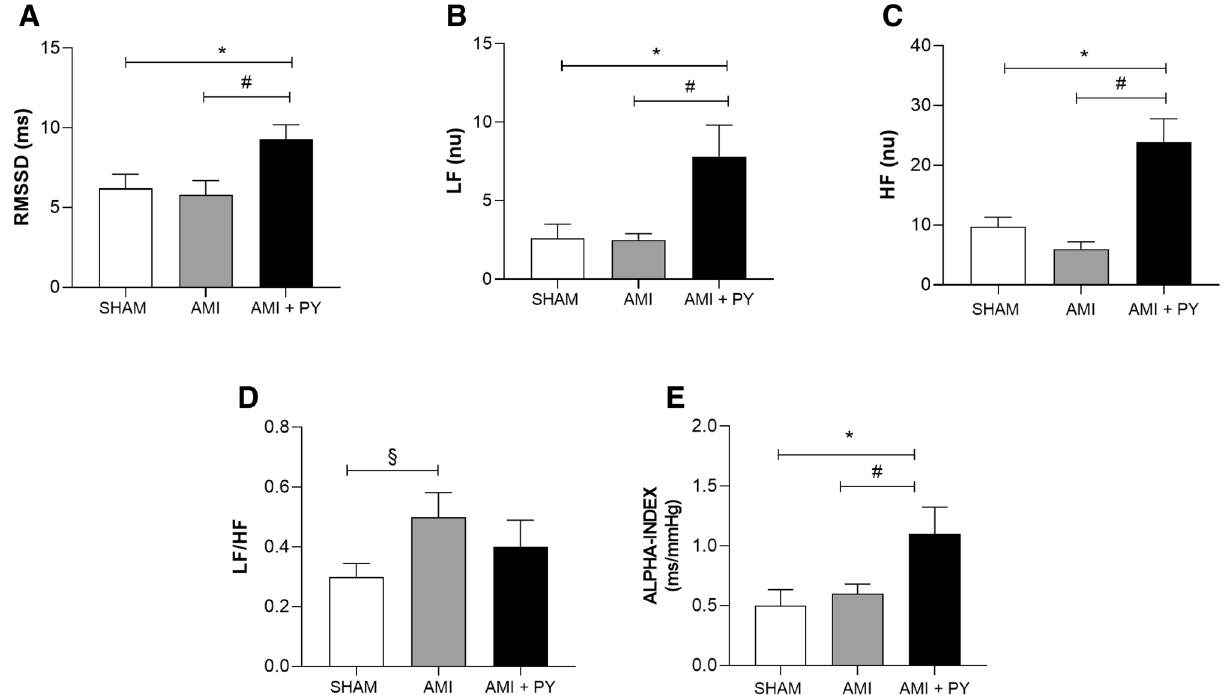
Figure 2. Heart rate variability (HRV) and Baroreflex Sensitivity (alpha-index). ( A ) RMSSD: square root of the mean of the sum of squares of the differences between successive pulse interval values. ( B ) LF: Low Frequency nu: Normalized units. ( C ) HF nu: high frequency in normalized units and. ( D ) LF/HF ( E ) ALPHA-INDEX: baroreflex sensitivity. * P < 0.05 versus Sham; # P < 0.05 versus AMI and § p < 0.05 versus AMI. Values expressed as mean ± SEM. Statistical significance was determined by one-way ANOVA followed by a multiple comparisons test Tukey’s was performed using GraphPad Prism version 9.0.1. www. graph pad. com.